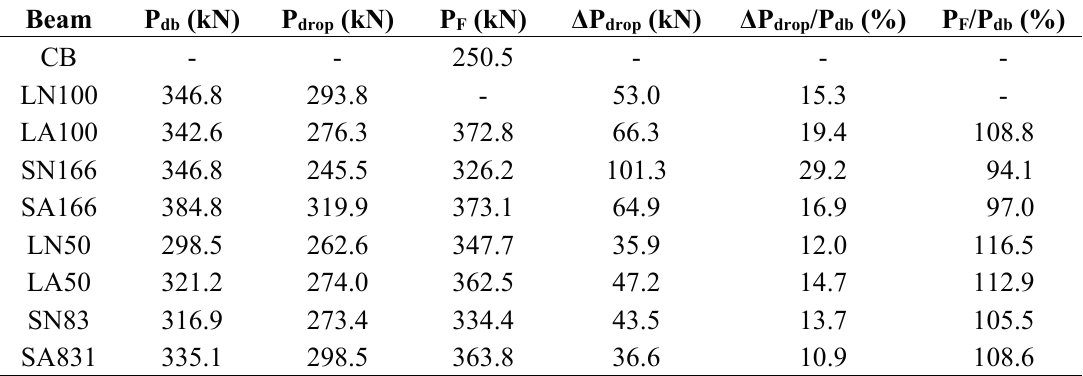
Table 4. Debonding load, drop in load after debonding and the failure load for the test beams.